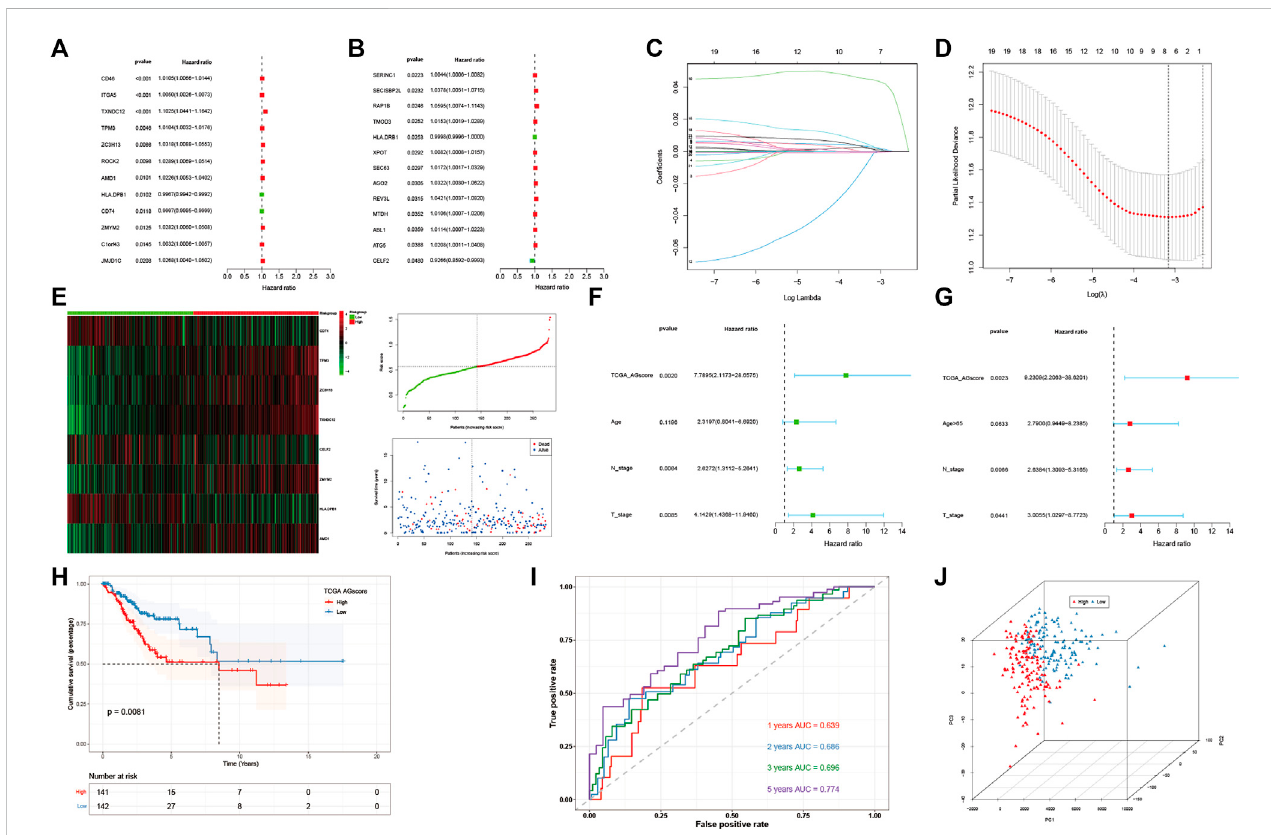
FIGURE 3 Construction and evaluation of angiogenesis-related prognostic model. (A,B) . 25 AG genes associated with prognostic screened by univariate cox analysis. (C,D) .Distribution oflassoregressioncurves. (E) HeatmapandpointplotsforassessingtheriskdistributionofpatientsofTCGA-CESCcohortinhigh- and low-AGS groups. (F) Univariate cox analysis of AG modeling scores and clinical characteristics. (G) . Multivariate cox analysis of AG modeling scores and clinical characteristics. (H) . Survival analysis for TCGA-CESC cohort in high- and low-AGS groups. (I) . ROC curves of TCGA-CESC cohort. (J) . PCA analysis in TCGA-CESC